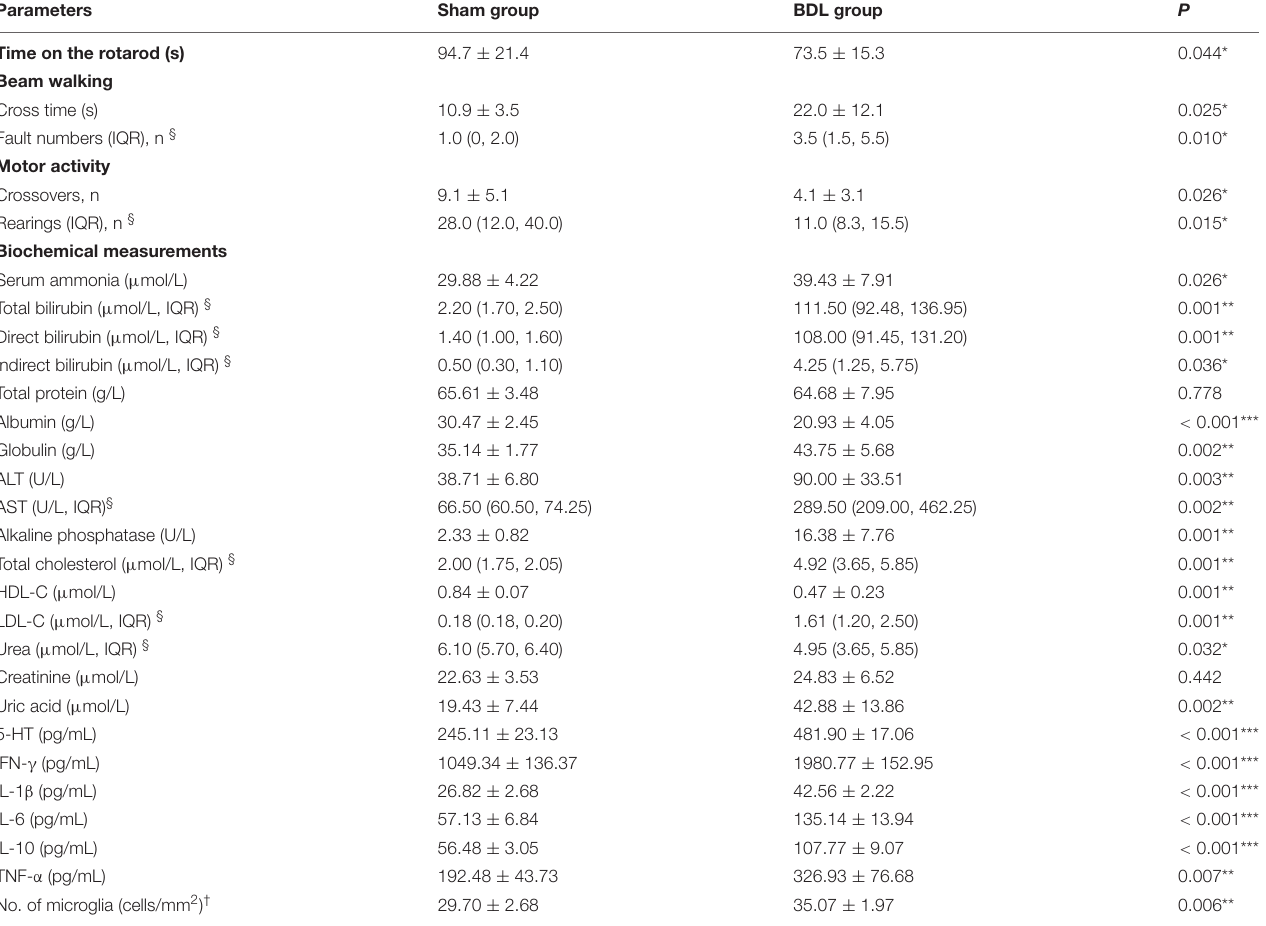
TABLE 1 | Comparisons of behavioral, biochemical, and histopathological measurements between sham and BDL rats.